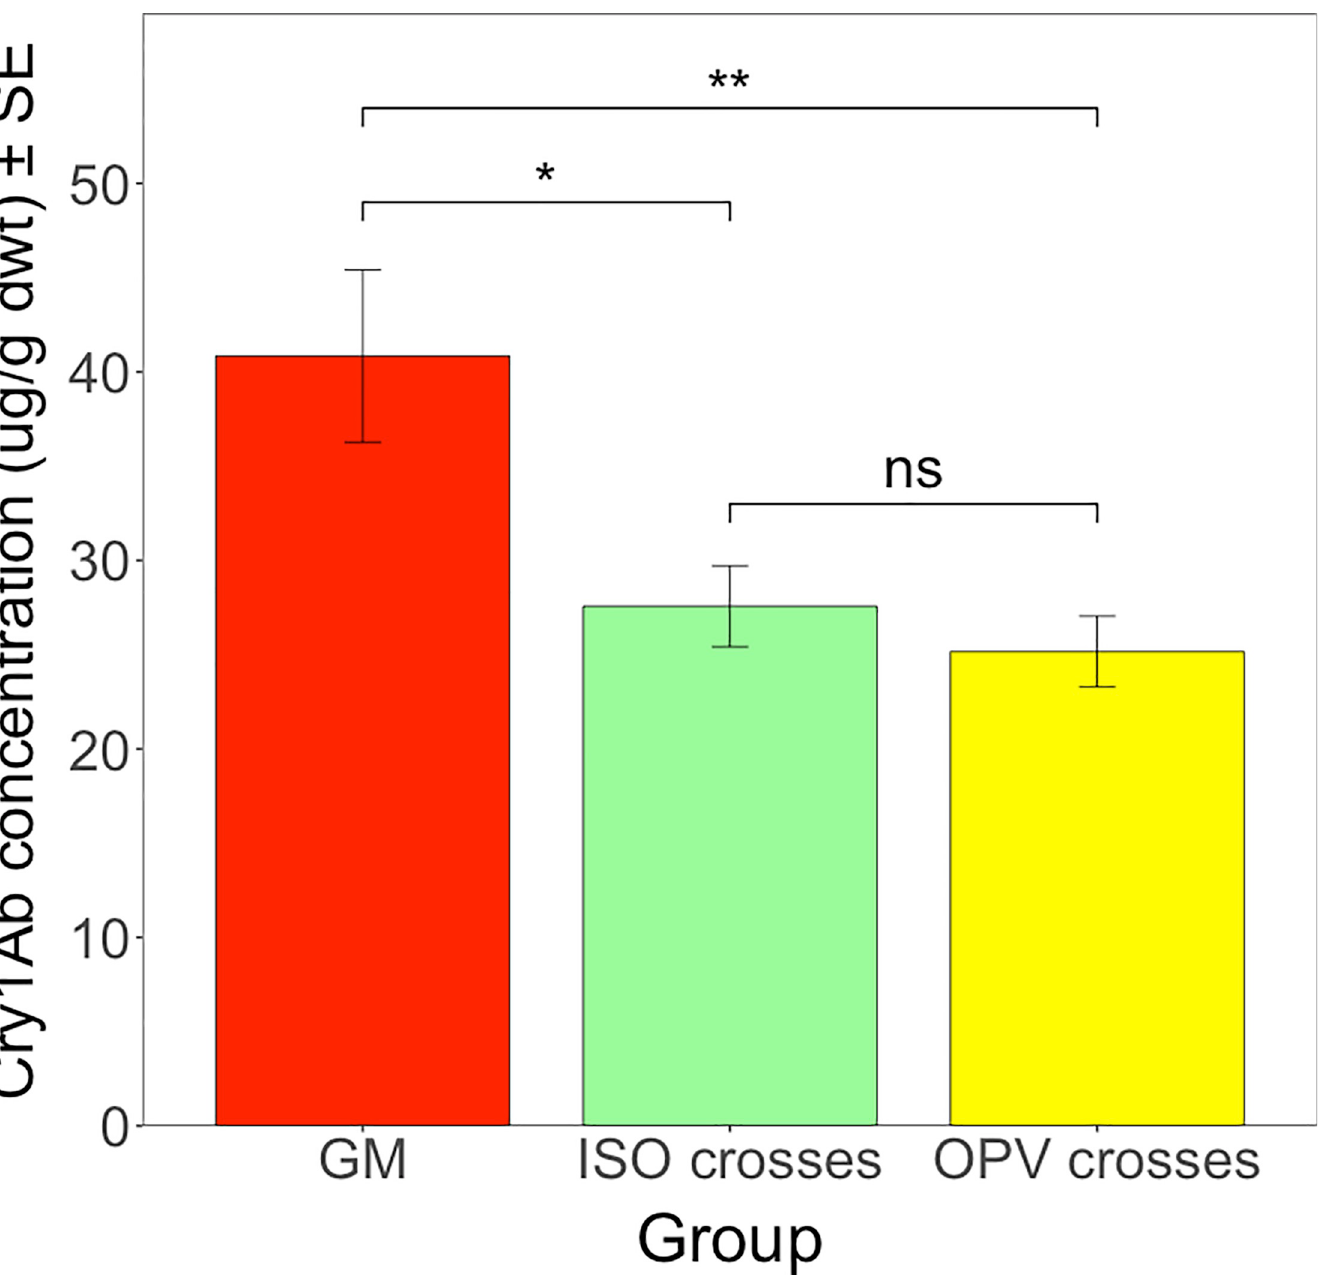
Fig 3. Mean Cry1Ab concentration ( μ g/g dwt) in different groups from South Africa. Vertical bars show mean values, with standard error ( ± SE) indicated as lines. � P < 0.05, �� P < 0.01, ns = not